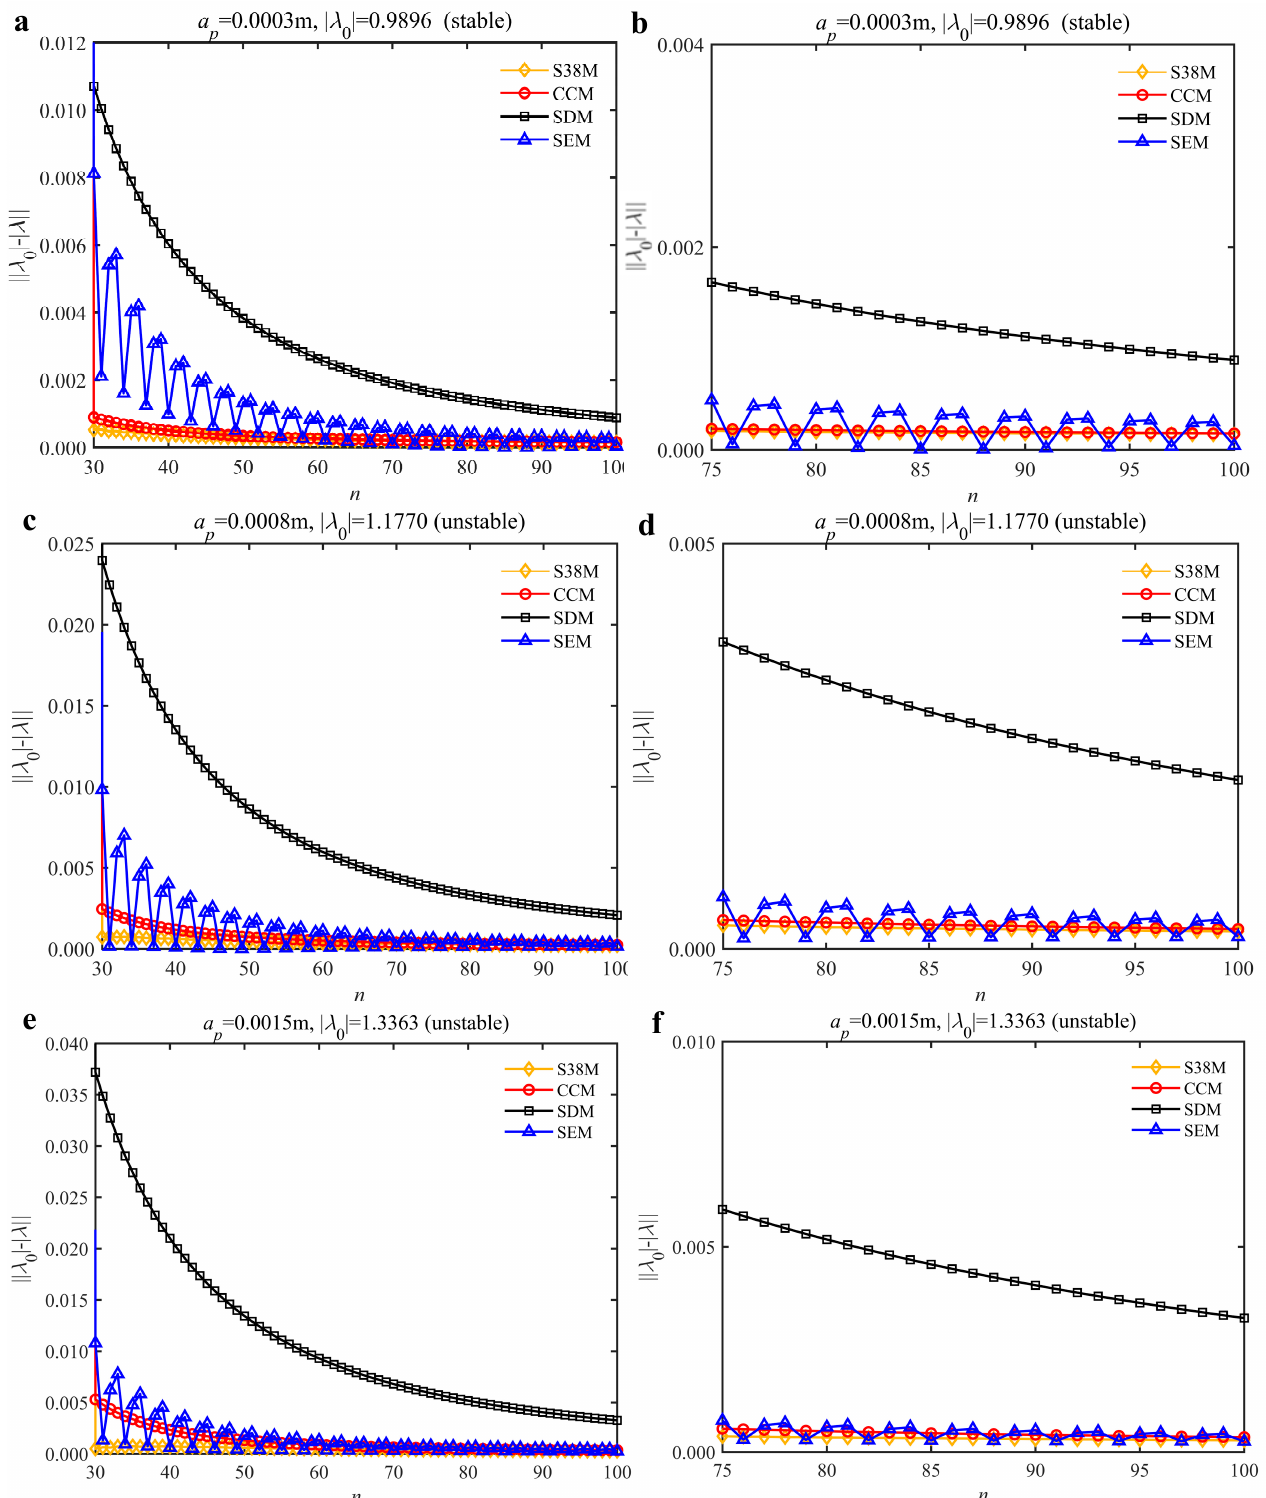
Figure 8. Convergence rate comparisons of the S38M, CCM, SDM, and SEM when v = 10000 rpm and a / D = 1. ( a ) a p = 0.0003 m and n ∈ [30,100]; ( b ) a p = 0.0003 m and n ∈ [75,100]; ( c ) a p = 0.0008 m and n ∈ [30,100]; ( d ) a p = 0.0008 m and n ∈ [75,100]; ( e ) a p = 0.0015 m and n ∈ [30,100]; ( f ) a p = 0.0015 m and n ∈ [75,100]. The low-immersion condition can be utilized to verify the stability of the convergence rate [25]. The radial immersion ratio is set as 0.05; that is, a / D = 0.05. The depths of cut are